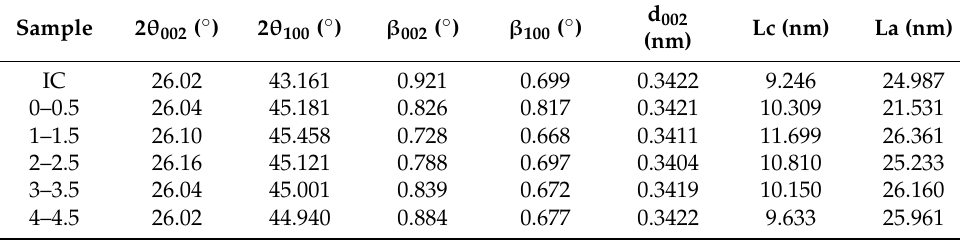
Table 4. Microcrystalline parameters of coke in different radial directions of the tuyere plane.